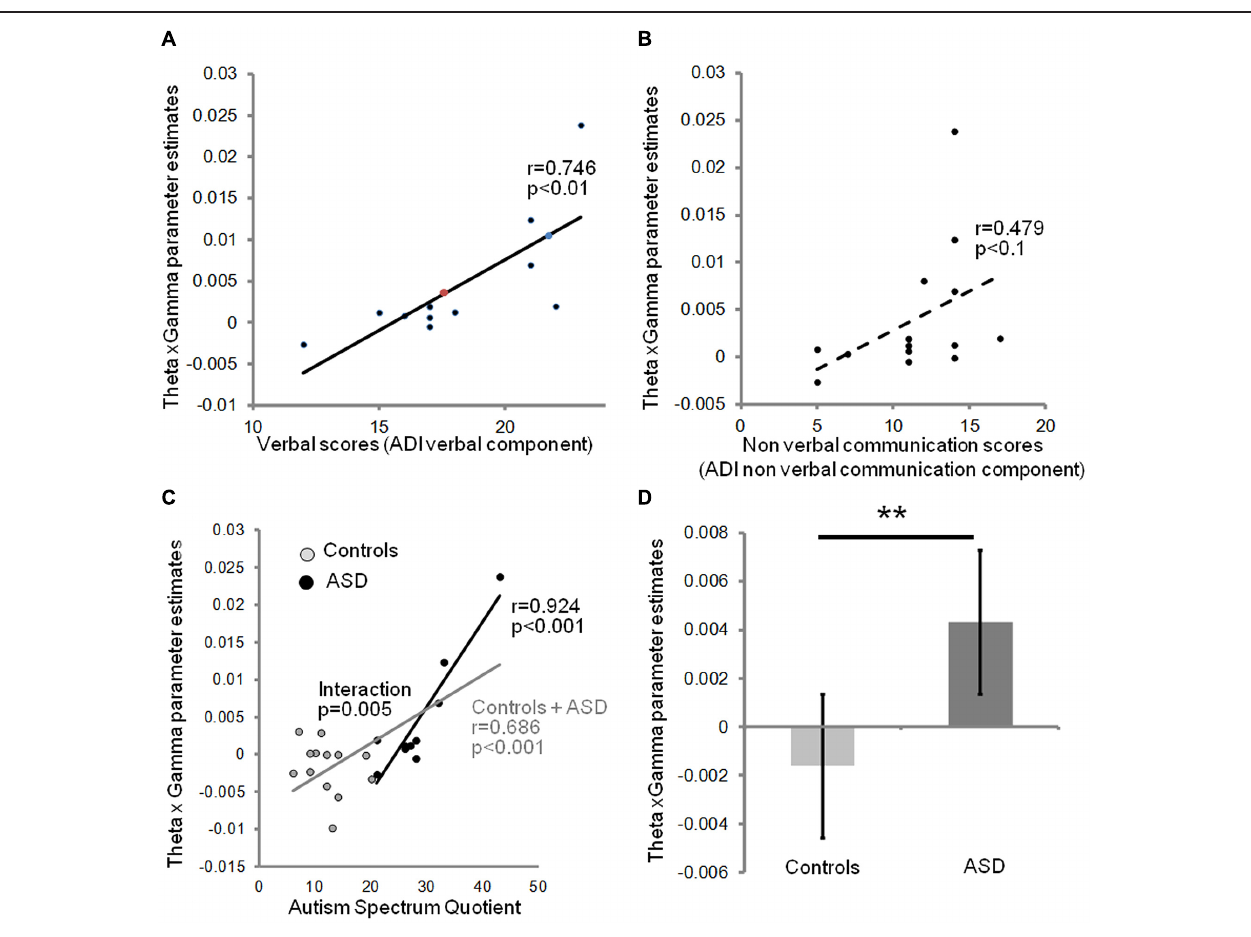
FIGURE 3 | Relationship between theta/gamma-BOLD interaction term, and clinical data: the neurophysiological theta × gamma variable predicts the verbal component of ADI (A), but not the non-verbal communication component (B). Colored dots indicate the predicted ADI score of the dysphasic subjects: the blue one was deeply dysphasic and the red one was moderately dysphasic; note the high ADI predicted score of the non-verbal one. The theta × gamma variable closely predicts autism severity